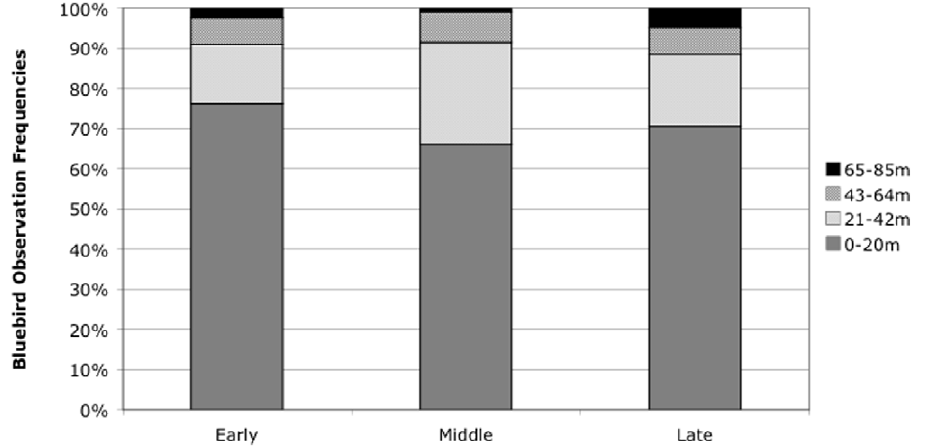
Figure 1. Frequency of Western Bluebird observations categorized as distance (in m) from active nest box locations during the breeding season (x-axis).